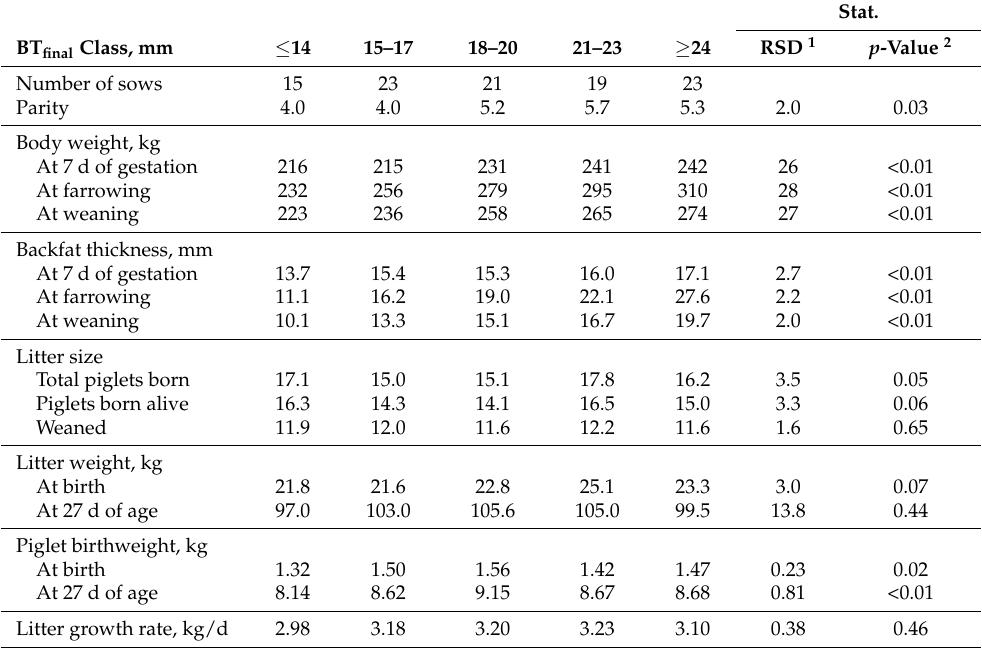
6 sows/pen Stat.